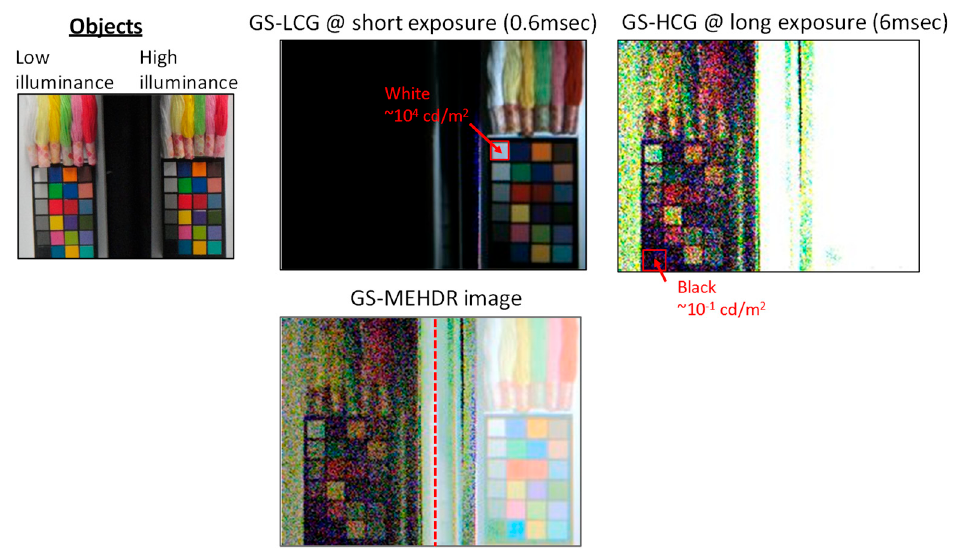
Figure 15. Sample images captured in the global shutter (GS) multiple exposure high dynamic range (MEHDR) mode.